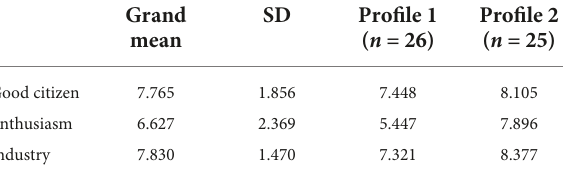
TABLE 5 Mean levels of role orientation factors in the two-latent-profile solution ( t 2 ).